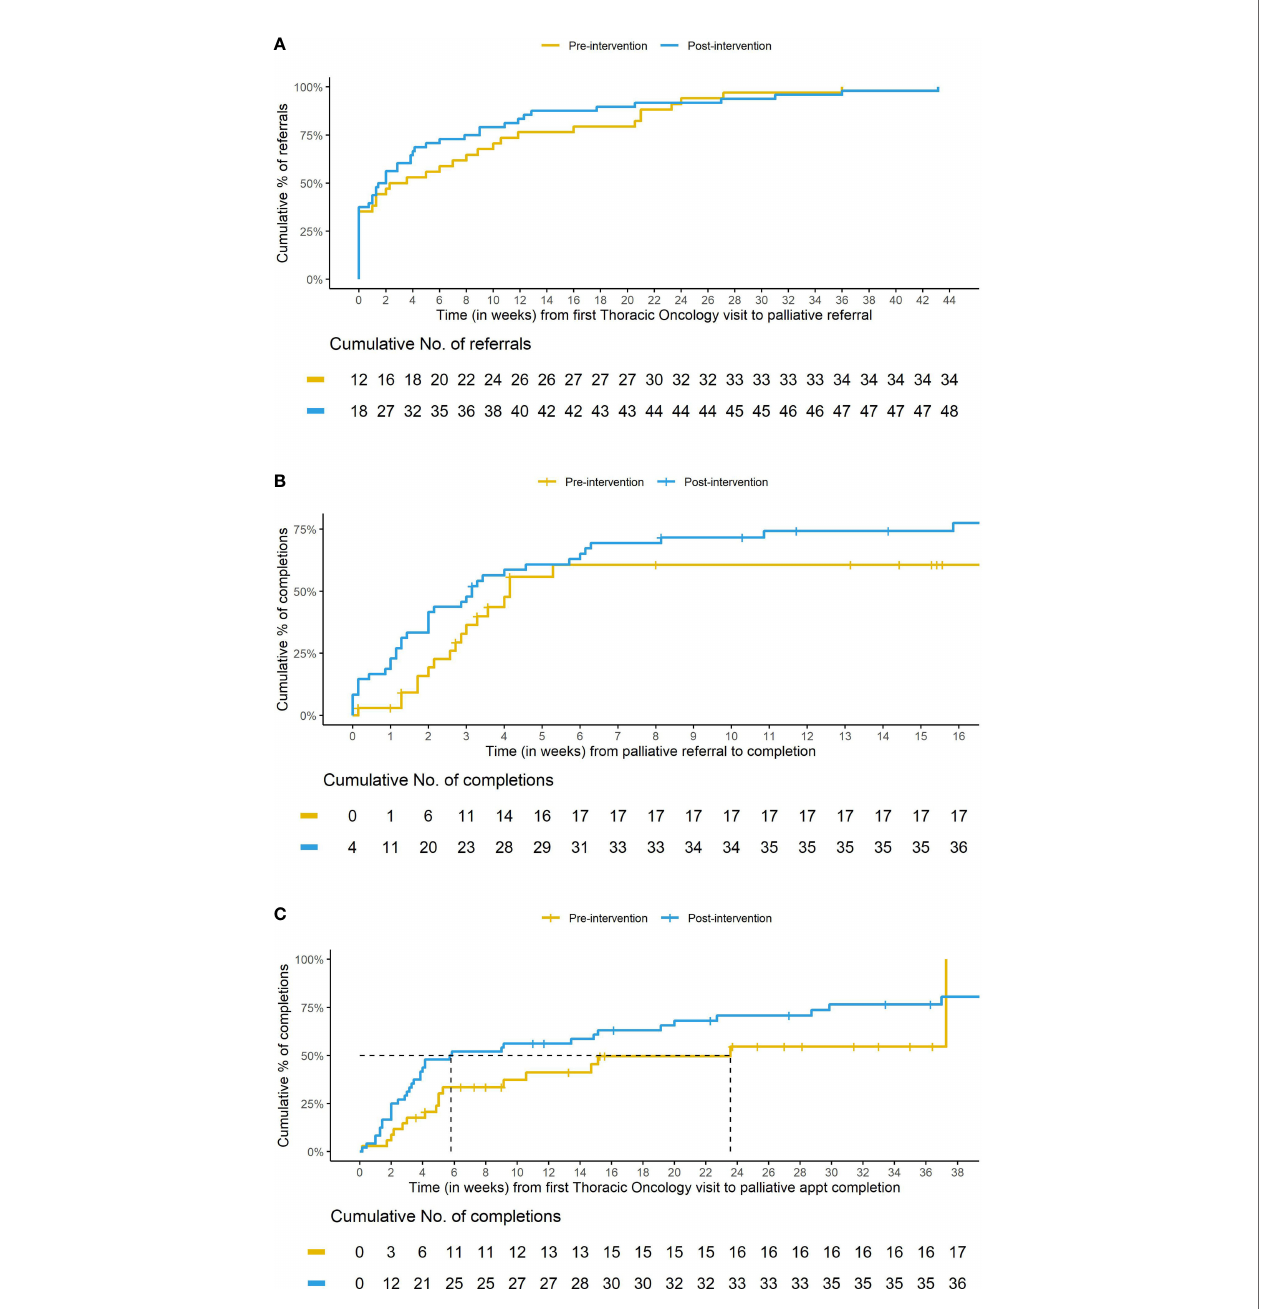
FIGURE 2 | Cumulative incidence curves comparing pre- versus post-cohort. Caption: (A) Time (in weeks) from fi rst Thoracic Oncology visit to palliative referral for patients with a palliative referral. Caption (B) Time (in weeks) from palliative referral to palliative appointment completion. Caption (C) Time (in weeks) from fi rst Thoracic Oncology visit to palliative appointment completion for those with a palliative referral. Note the shorter length of time to median palliative appointment completion for those in the post- cohort. This decrease is likely due to patients being referred earlier (A) and completing their palliative appointment sooner (B)